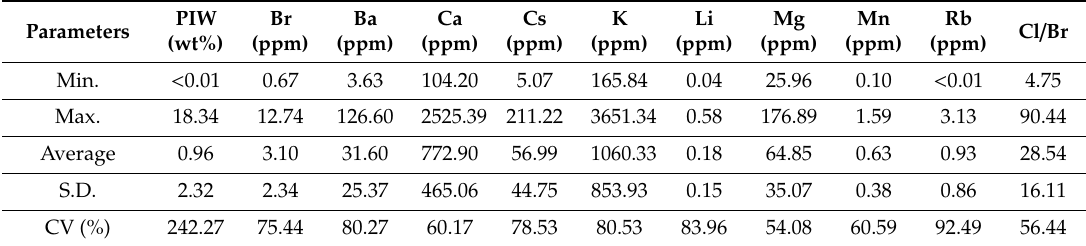
Table 2. The main statistical parameters of salt rocks chemical composition.